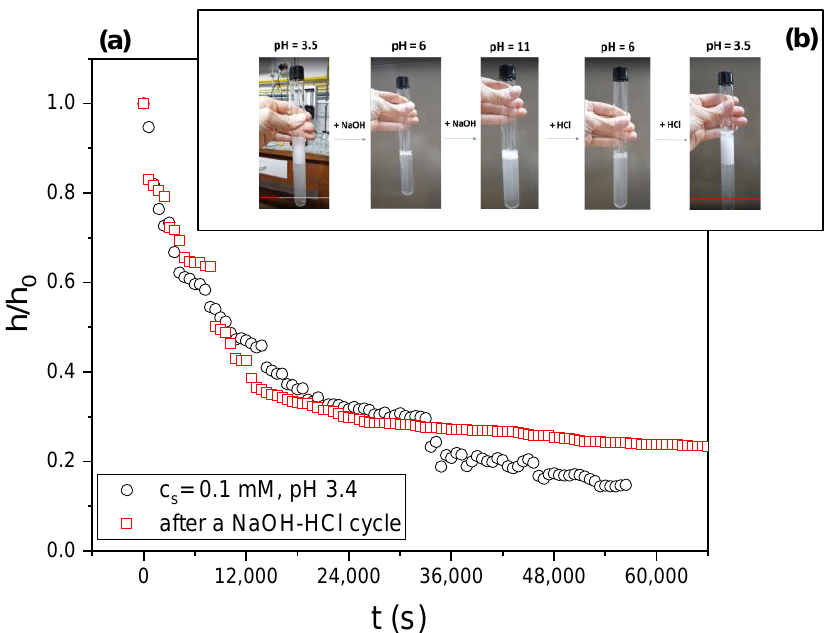
Figure 12. ( a ) Relative foam height, h/h 0 (h 0 is the initial foam height). as a function of time for the same sample before and after a NaOH-HCl cycle that takes the pH from 3 to 11 and then back to 3. ( b ) Sequence of images showing the foam produced immediately after 20 s agitating the liquid; each photo corresponds to a step in the NaOH-HCl cycle from pH 3.5 to 11 and back.